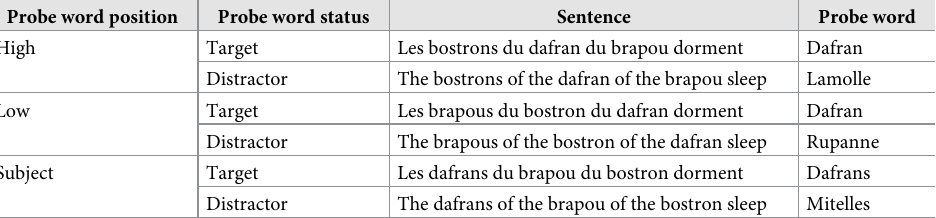
Table 5. Illustration of the distribution of probe words in the 6 experimental conditions involving an item with the modifier structure and the plural feature situated on the subject in Experiment 2. The same distribution applied to the corresponding 6 versions of that item in the Object condition. Probe words were either present in the sentence (Target) or not (Distractor), and if present in the sentence, it could be in 3 different positions: Subject, High attractor or Low